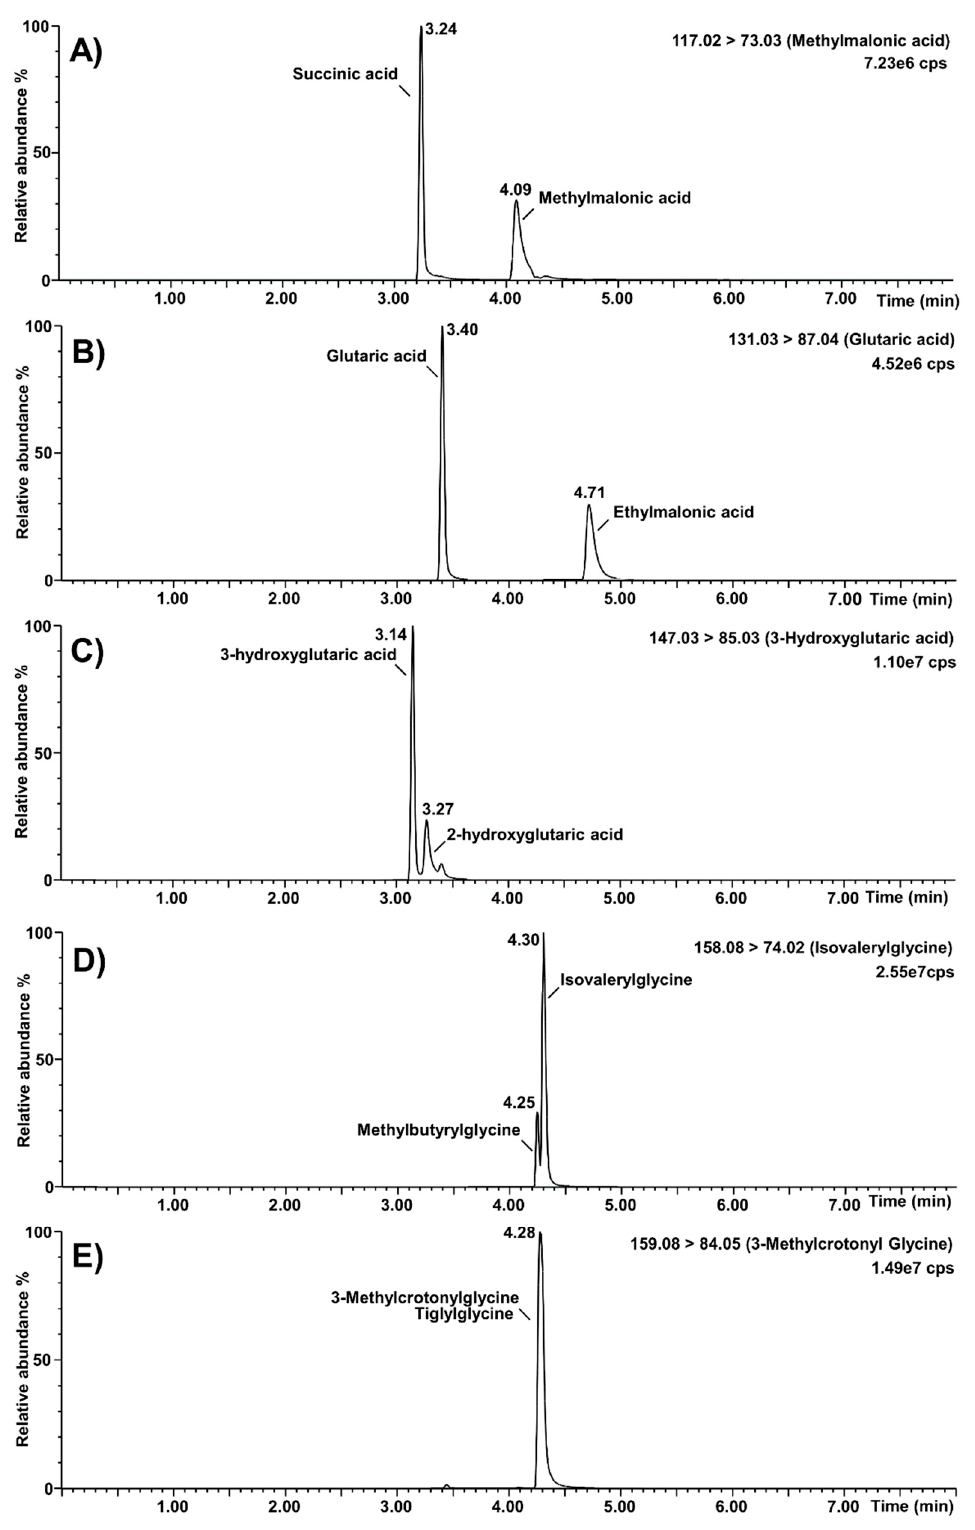
Figure 5. Selectivity of the organic acids second-tier test regarding known isobaric interferences. ( A ): Separation of methylmalonic acid from succinic acid; ( B ): separation of glutaric acid from ethylmalonic acid; ( C ): separation of 3-hydroxyglutaric acid from 2-hydroxyglutaric acid; ( D ): separation of isovalerylglycine from methylbutyrylglycine; ( E ): unseparated peaks of 3-methylcrotonylglycine and tiglylglycine; cps: counts per second.